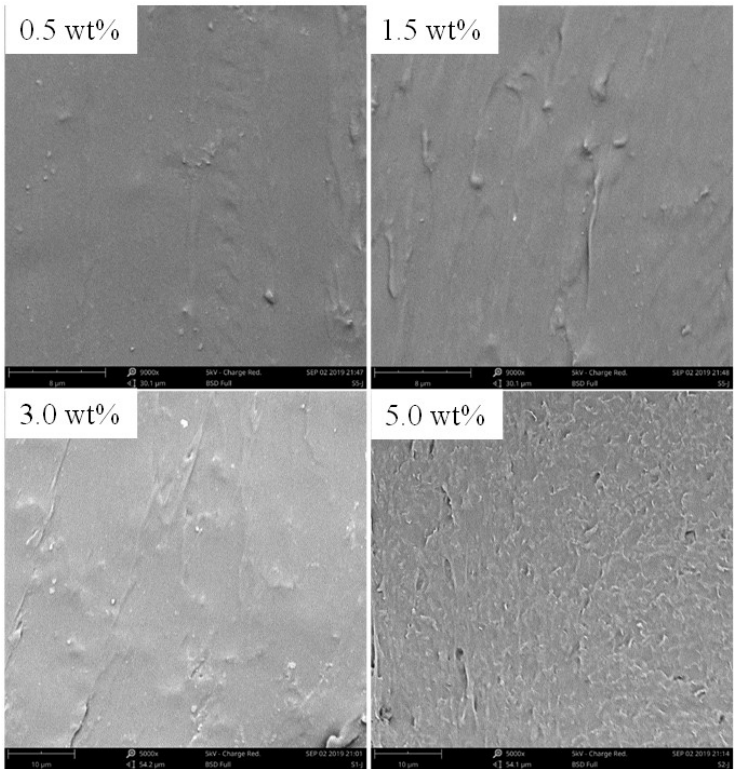
Figure 3. SEM images of the cross-section morphology of the composite films with different mass contents of graphene.